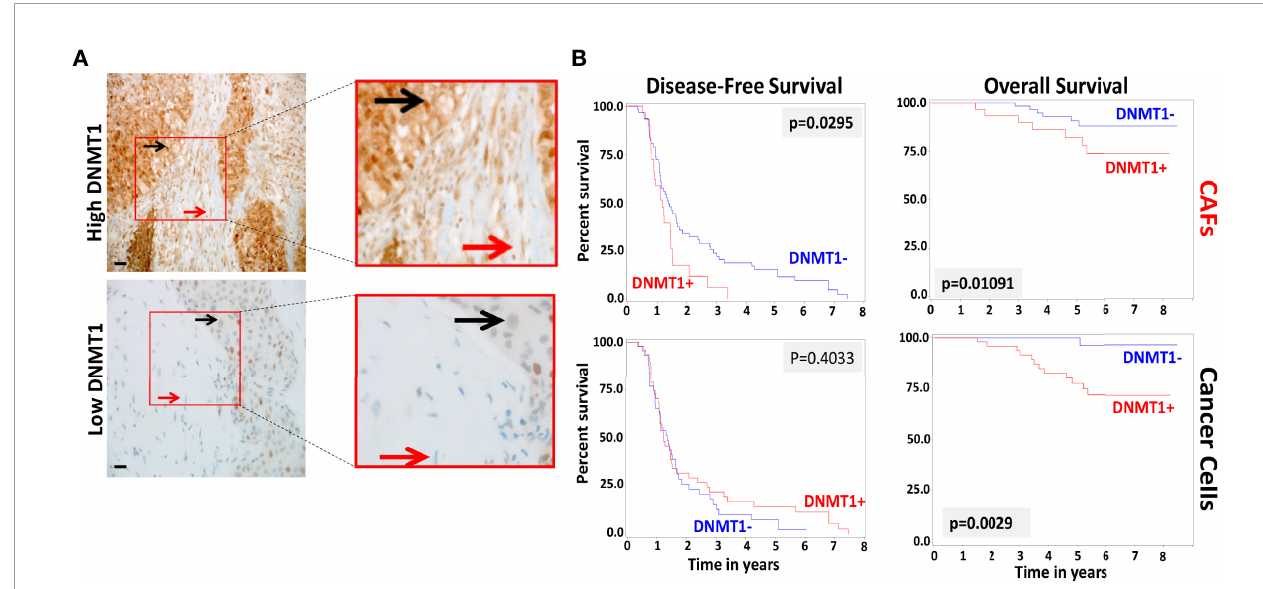
FIGURE 4 | Loss of DNMT1 in stromal and tumoral cells is predictive of poor disease-free and overall survival. (A) Tissue sections cut from formalin- fi xed paraf fi n embedded breast tumors were immunostained with an anti-DNMT1 antibody. Red arrows indicate stromal fi broblasts, black arrows indicate cancer cells. (Envision 60x). (B) Kaplan-Meier analysis of overall survival (OS) and disease-free survival